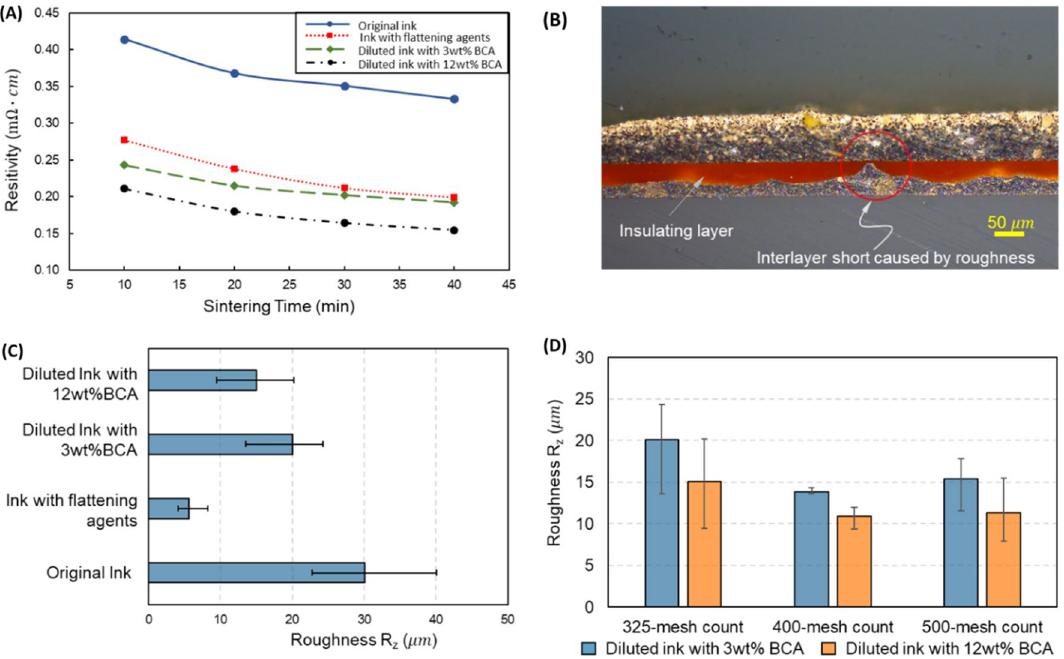
Figure 3. Conductive layers patterning. ( A ) the resistivity of printed patterns using different inks, ( B ) roughness causing interlayer shortage, ( C ) roughness of the printed patterns with respect to the inks, and ( D ) roughness regarding the screen